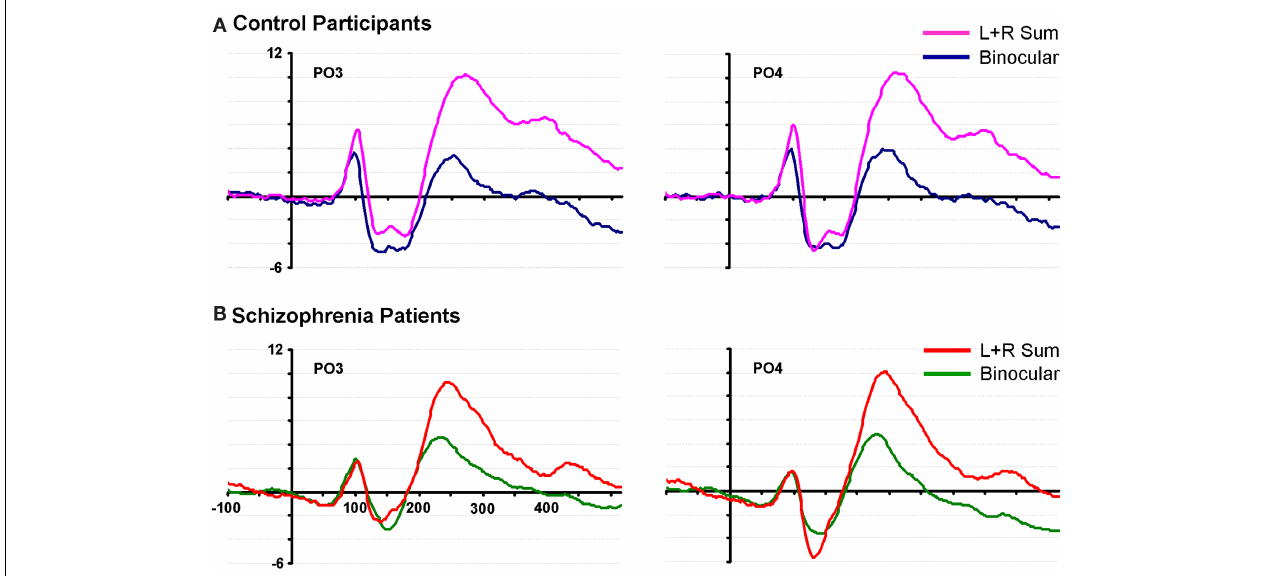
FIGURE 1 |Waveforms from two representative parieto-occipital scalp sites (PO3 and PO4) are shown for neurotypical control participants and patients with schizophrenia . (A) Data from 20 control subjects are displayed in pink and blue; (B) data from 20 patients are displayed in red and green.